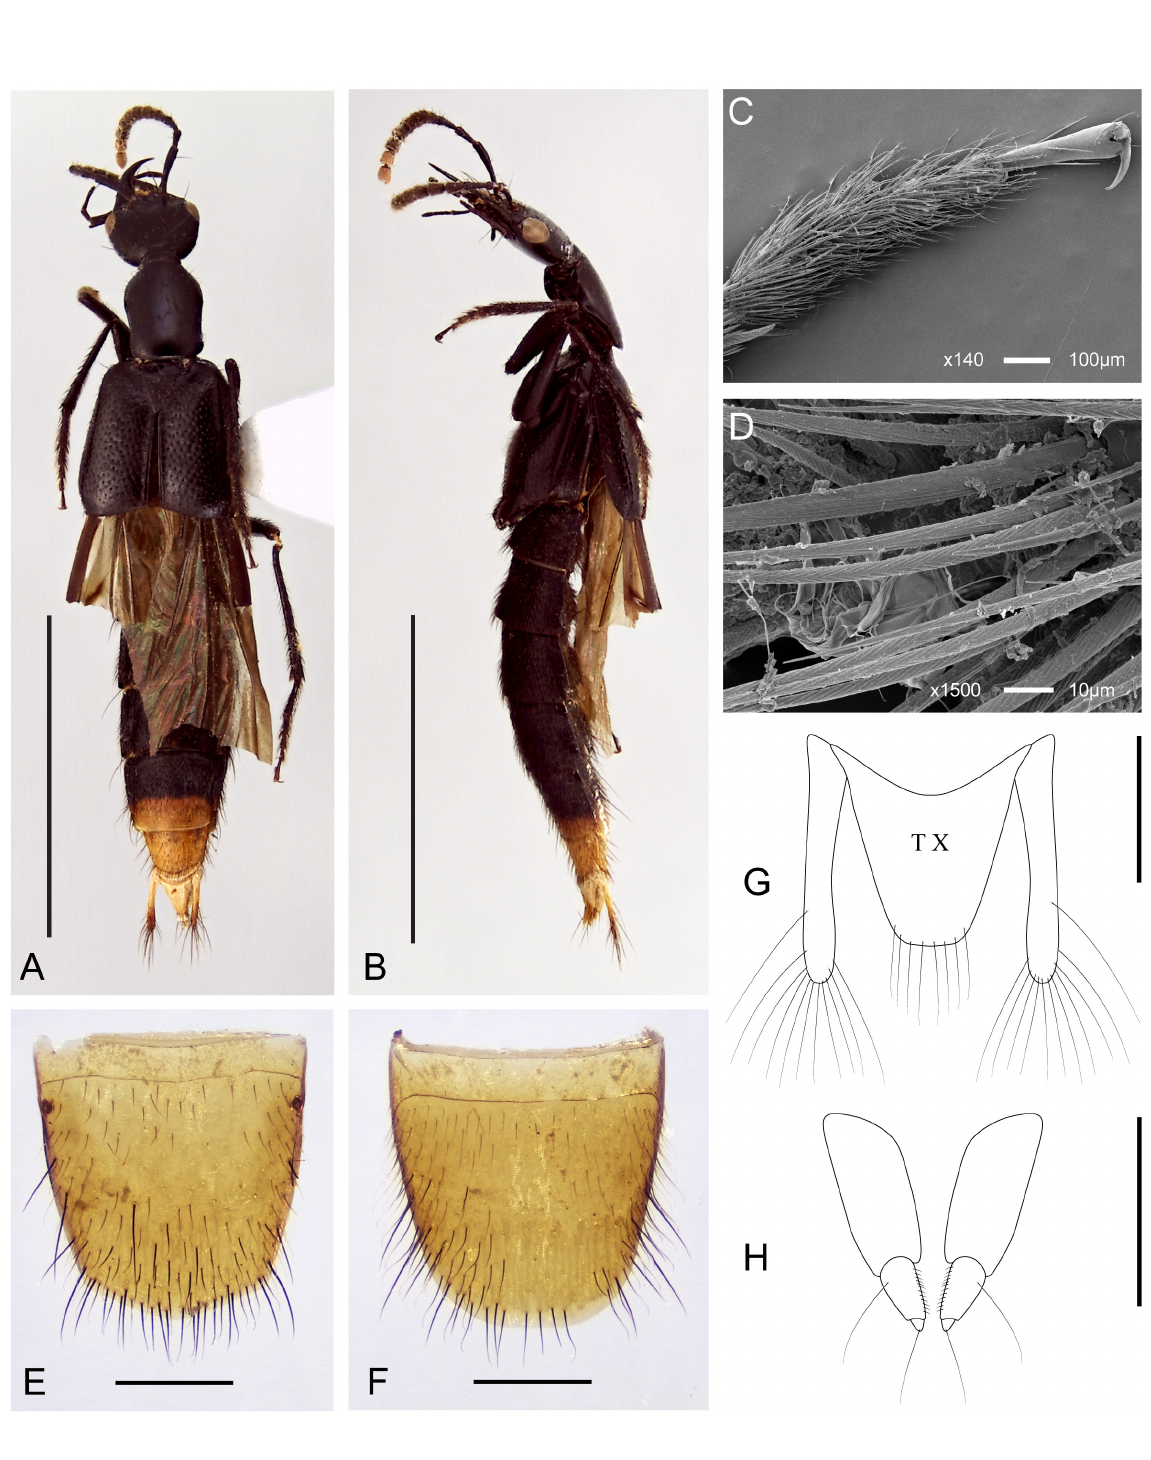
Fig. 2. Ophionthus serpentinus Bernhauer, 1908. ♀ (MUSM). A . Habitus, dorsal view. B . Habitus, lateral view. C . Right protarsomeres, ventral view. D . Details of discal setae from right third protarsomere, ventral view. E . Tergum VIII. F . Sternum VIII. G . Lateral tergal sclerites IX and tergum X. H . Gonocoxites of female genital segment. Scale bars: A–B = 5 mm; G–H = 0.5